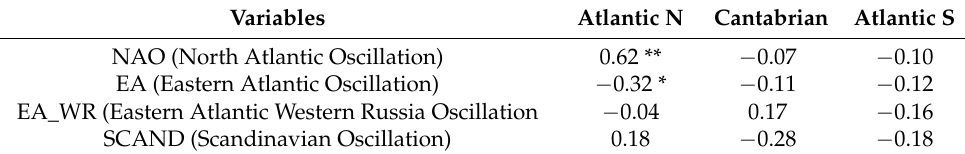
Table 4. Values of the Pearson Correlation coefficient between the PC scores corresponding to each region and the corresponding values of the main teleconnection patterns affecting the Atlantic and Europe. ** stands for values statistically significant at the 99% confidence level; * stands for values statistically significant at the 95% confidence level. Variables Atlantic N Cantabrian Atlantic S NAO (North Atlantic